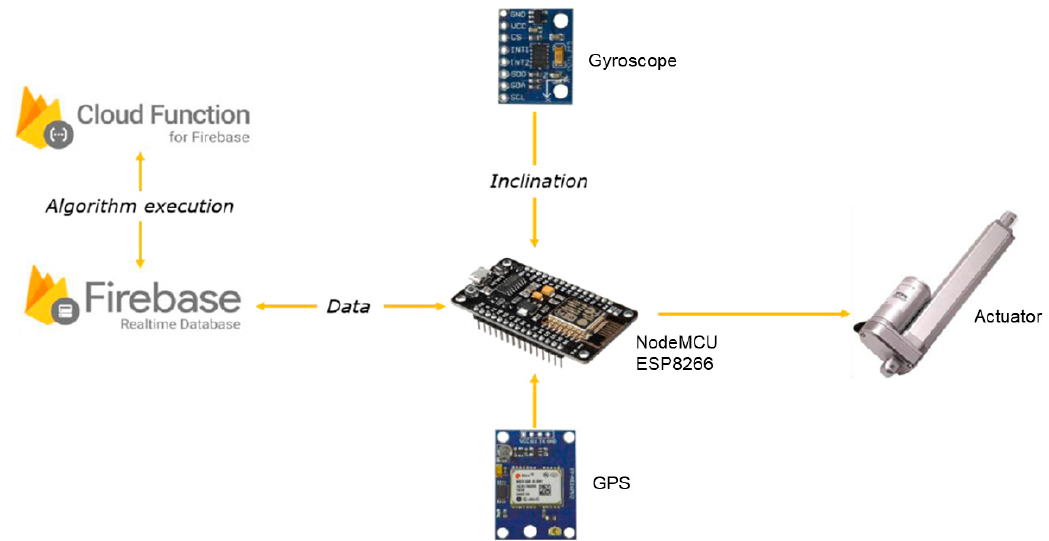
Figure 8. Principal components of the IoT architecture system.